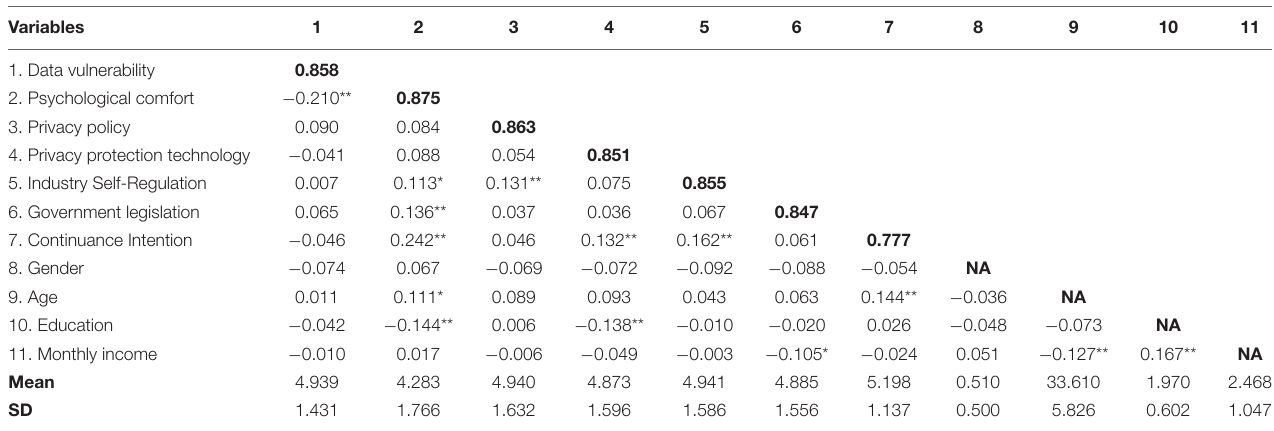
TABLE 2 | Correlations.